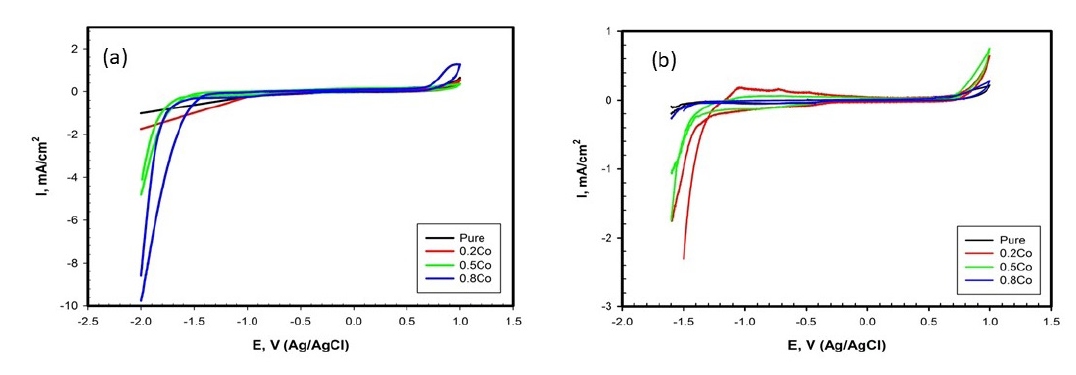
Figure 10. Cyclic voltammetry at scan rate of 50 mV/S in 1.0 M KOH for Zinc Ferrite and Co-Zinc Ferrite prepared by (a) solid state at 800 o C (b) microwave at 1000 o